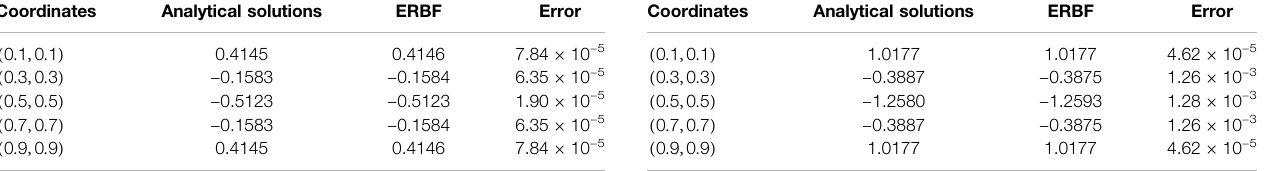
TABLE 2 | The comparison of the absolute errors at t (cid:2) 0.9 s.